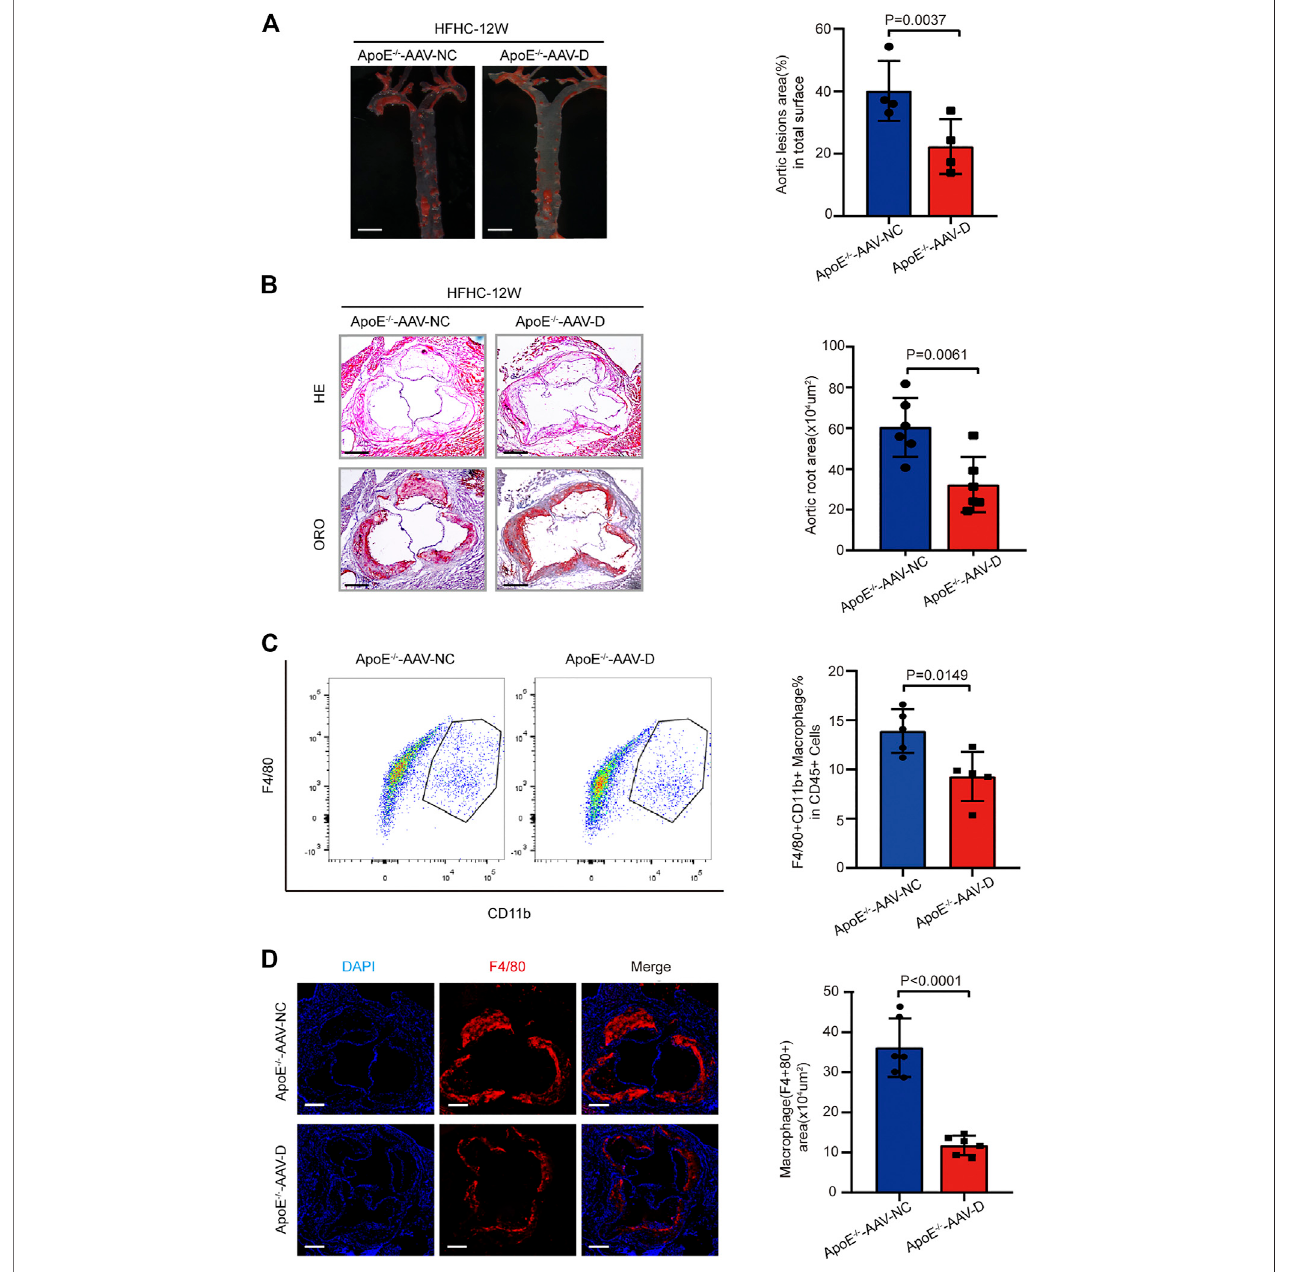
FIGURE 5 | Suppression of gasdermin D attenuated atherosclerosis plaque progression and macrophage in fi ltration in ApoE − / − mice. (A) Left, overall comparison ofrepresentativewhole-aortasstainedwithOil-Red-Ostaining( n (cid:2) 5micepergroup;scalebar,1 mm).Right,quantitativeresultsofthestainedareaintheentireaortasof ApoE − / − miceadministeredwithvectorAAV-gasderminDorthecontrolvectorAAV-controlafter12 weeksofHFHCdiettreatment. (B) Left,histologicalanalysisofaortic root sections stained with H&E and ORO staining in the aortic root sections of ApoE − / − mice administered with vector AAV-GSDMD or the control vector AAV- control after 12 weeks of HFHC diet treatment ( n (cid:2) 4 mice per group; scale bar, 100 μ m). Right, statistical analysis of the stained atherosclerotic lesion area in the aortic rootsectionsbyOROstainingintheindicatedgroups( n ≥ 20 fi eldspergroup). (C) Left, fl owcytometricanalysisofaorticmacrophagecontent,determined asF4/80and CD11bpositivecellsinApoE − / − mice administered vectorAAV-GSDMDorthecontrolvectorAAV-controlafter 12 weeksofHFHC diettreatment ( n (cid:2) 4mice per group). Right,statisticalanalysisofmacrophagecontentintheindicatedgroups. (D) Left,representativeimagesofF4/80(red)andDAPI(blue)inaorticrootsectionsoftheF4/80 positive area of aortic root sections in ApoE − / − mice administered vector AAV-GSDMD or the control vector AAV-control after 12 weeks of HFHC diet treatment ( n (cid:2) 4 mice per group; scale bar, 100 μ m). Right, quanti fi cation analysis of the F4/80 positive area and aortic area ratio in the indicated groups ( n ≥ 20 fi elds per group). Data shownaremean ± SD (A – D) .Datawere fi rstanalyzedandpassednormalitytest(Shapiro-Wilktest). p valueswereshownandassessedbyMann-Whitneytest (A – D) .All of the p values were labelled in the fi gure and p < 0.05 was considered to indicate statistical signi fi cance. AAV-D, AAV-5-gasdermin D; GSDMD, gasdermin D.